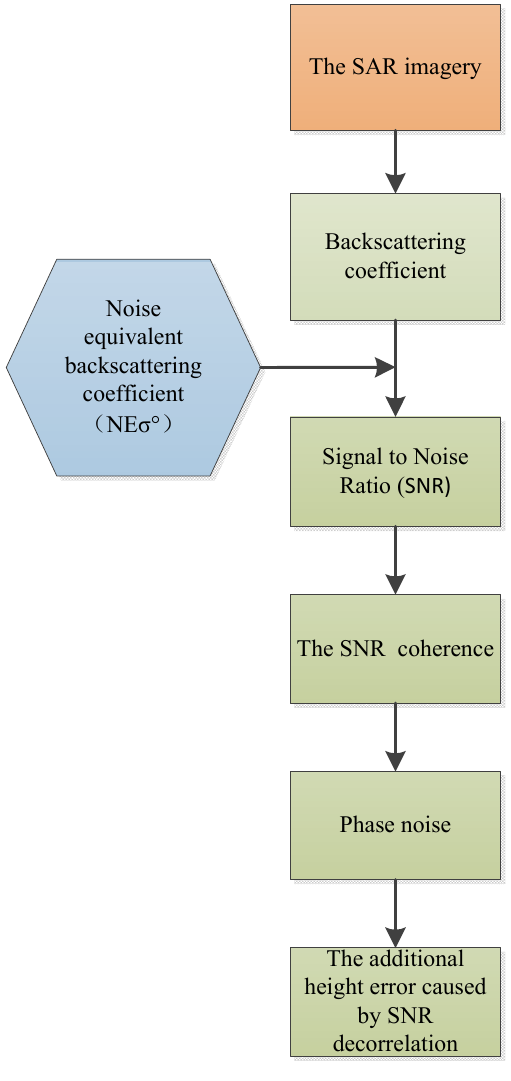
Figure 3. Workflow designed to estimate additional reference height error ∆ h errSNR